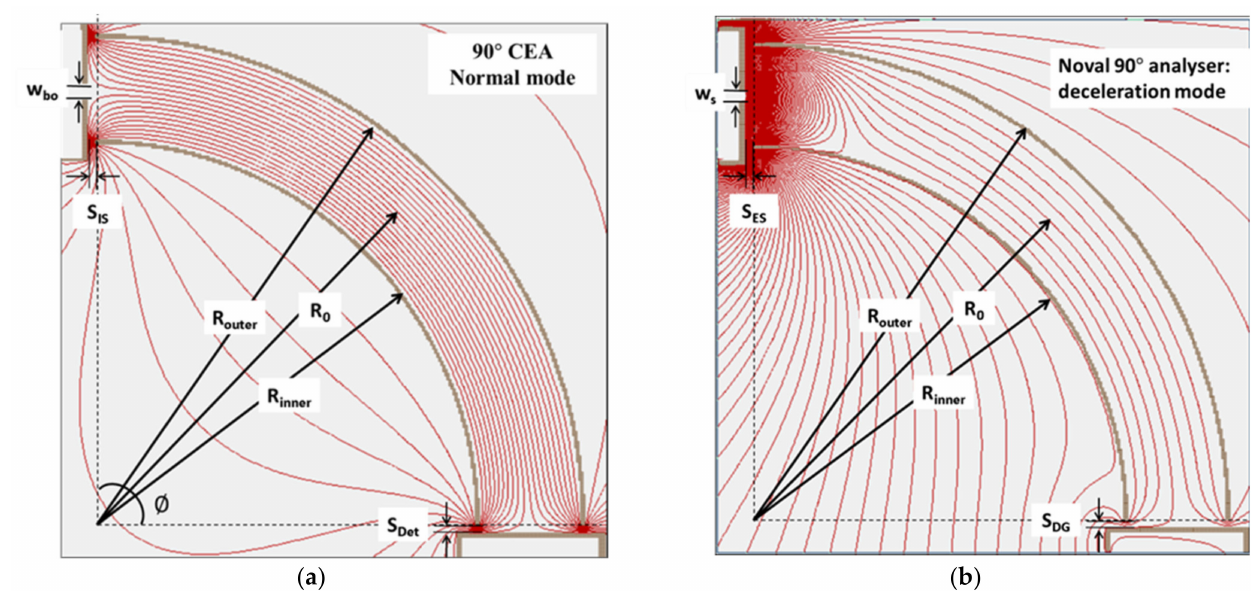
Figure 23. Representation of the equipotentials for the 90 ◦ cylindrical energy analyzer operating in normal mode ( a ) and the same analyzer operated in deceleration mode ( b